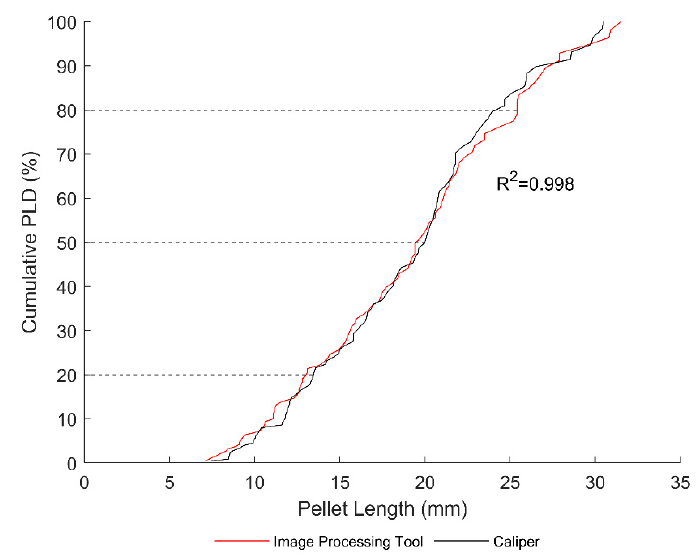
Figure 3. Pellet length distribution (PLD) measured by caliper and the in-house image processing tool.